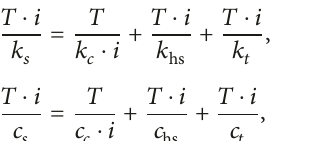
Figure 19: Slip ratio-friction coefficient